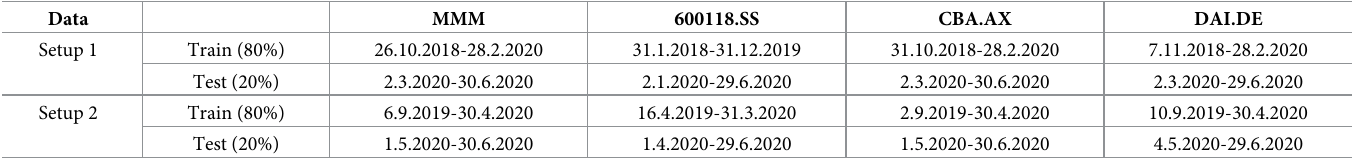
Table 3. Timespan considered for respective stocks during